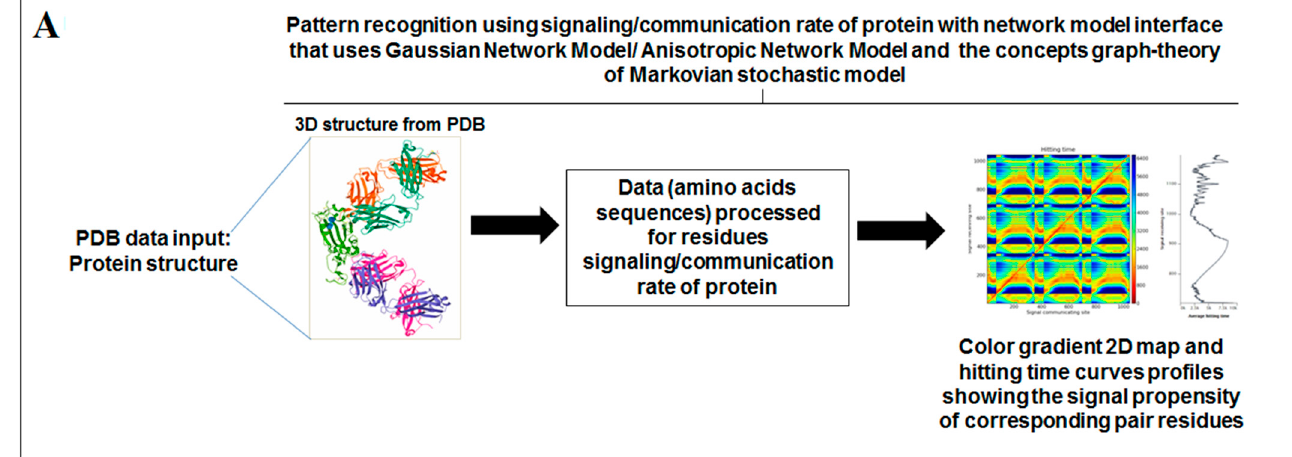
Figure 8. The schematic representation for the development of a 2D map of communication/signaling sites and hitting/signal communication times generated with protein residues using SARS-CoV-2 proteins and non-SARS-CoV-2 proteins. ( A ) The schematic representation for the development of a 2D map of communication/signaling sites and hitting/signal communication times generated with protein residues. ( B ) The 2D map for communication/signaling sites and hitting/signal communication times generated with protein residues of 3D structures of proteins which are used to develop the word “SARS CoV-2”. ( C ) The 2D map for communication/signaling sites and hitting/signal communication times generated with protein residues of 3D structures of proteins which are used to develop the word “COVID-19”. ( D ) The 2D map for communication/signaling sites and hitting/signal communication times generated with protein residues of 3D structures of two SARS-CoV-2 protein alphabets with antibodies/immunological or vaccine-associated roles used in this study. The complete analysis tried to capture the functionality of